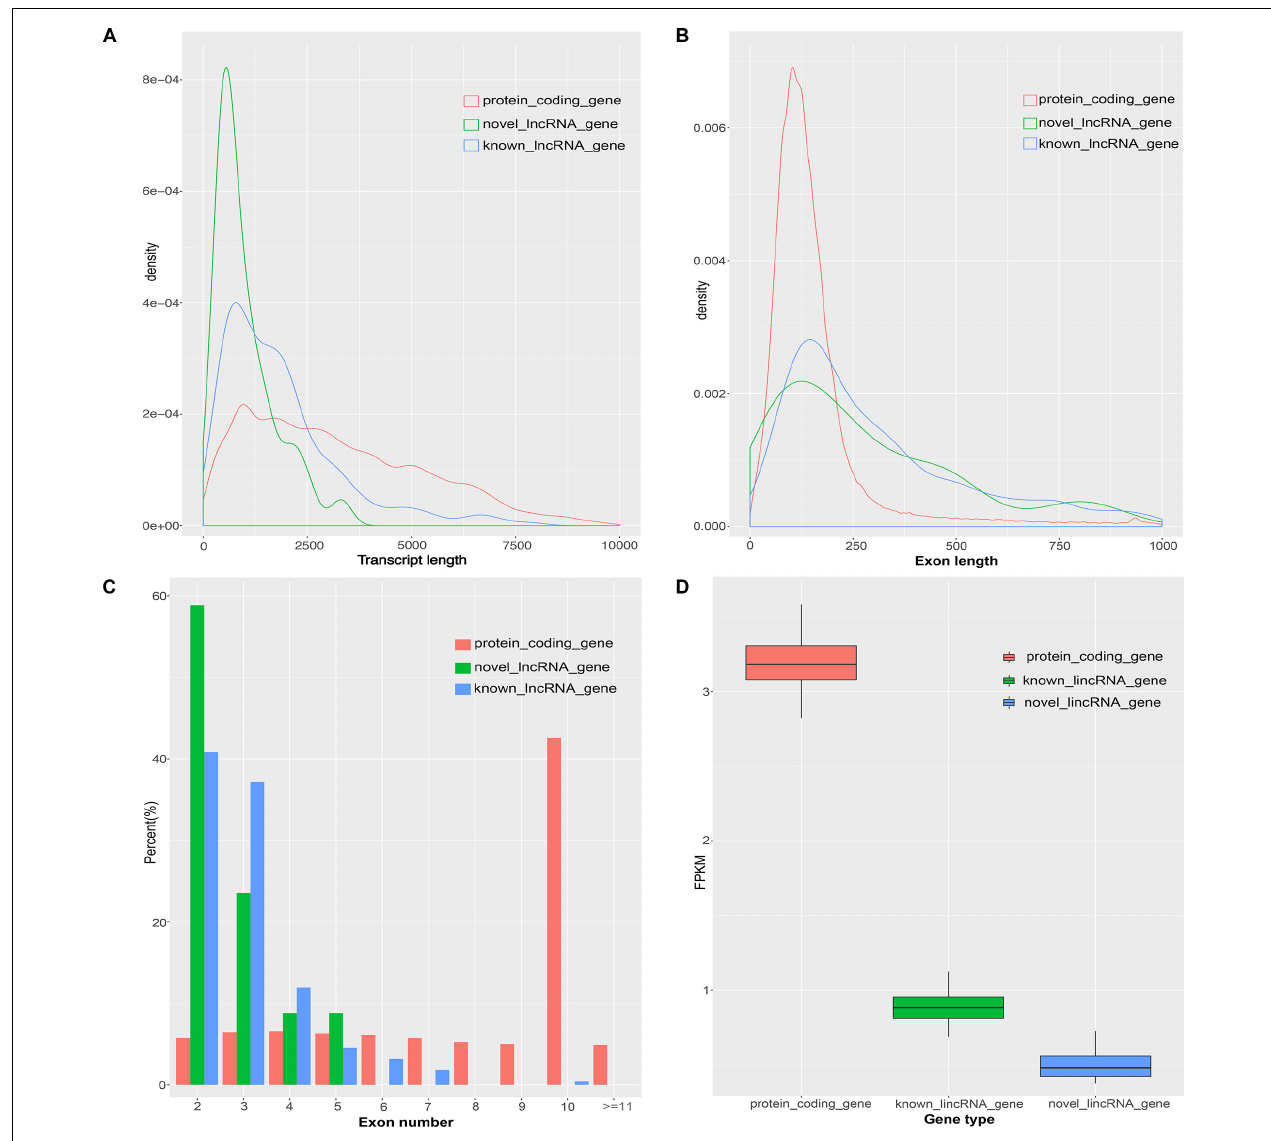
FIGURE 2 | Comparison of the characteristics of protein-coding genes, novel lincRNA genes and known lincRNA genes. (A) Comparison of transcript length. (B) Comparison of exon length. (C) Comparison of exon number. (D) Comparison of the expression